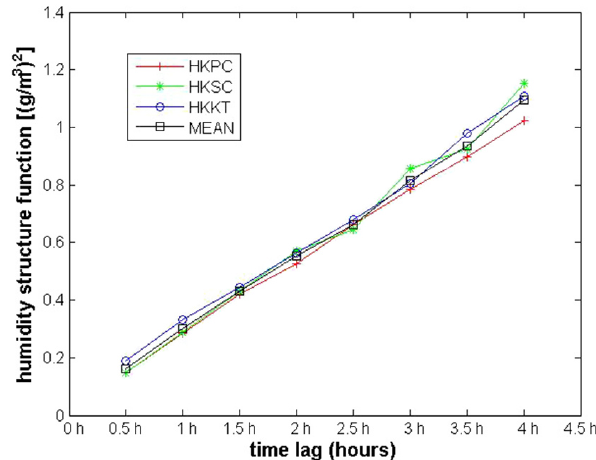
Figure 2. Humidity structure functions for the three lowest Hong Kong SatRef stations and their mean value. Altitude of GPS site HKPC is 18m, HKSC is 20m and HKKT is 34m. Average structure functions are calculated for the time lags from 30min to 4h using 1 year of